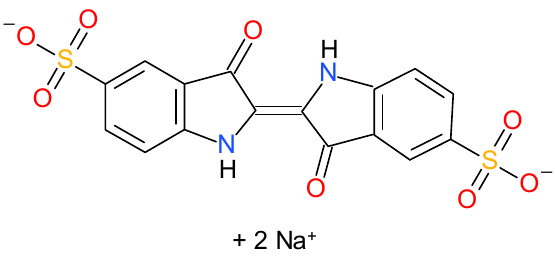
Figure 1. The chemical structure of indigo carmine (IC).